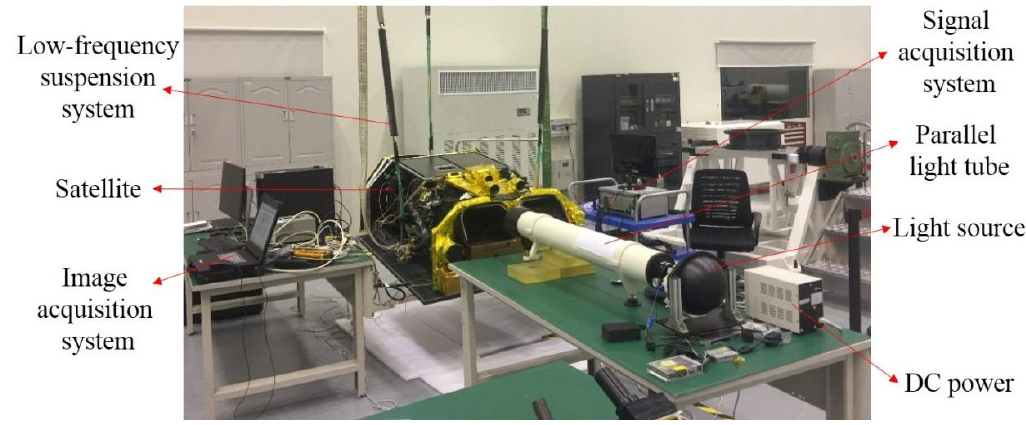
Figure 9. Test platform.